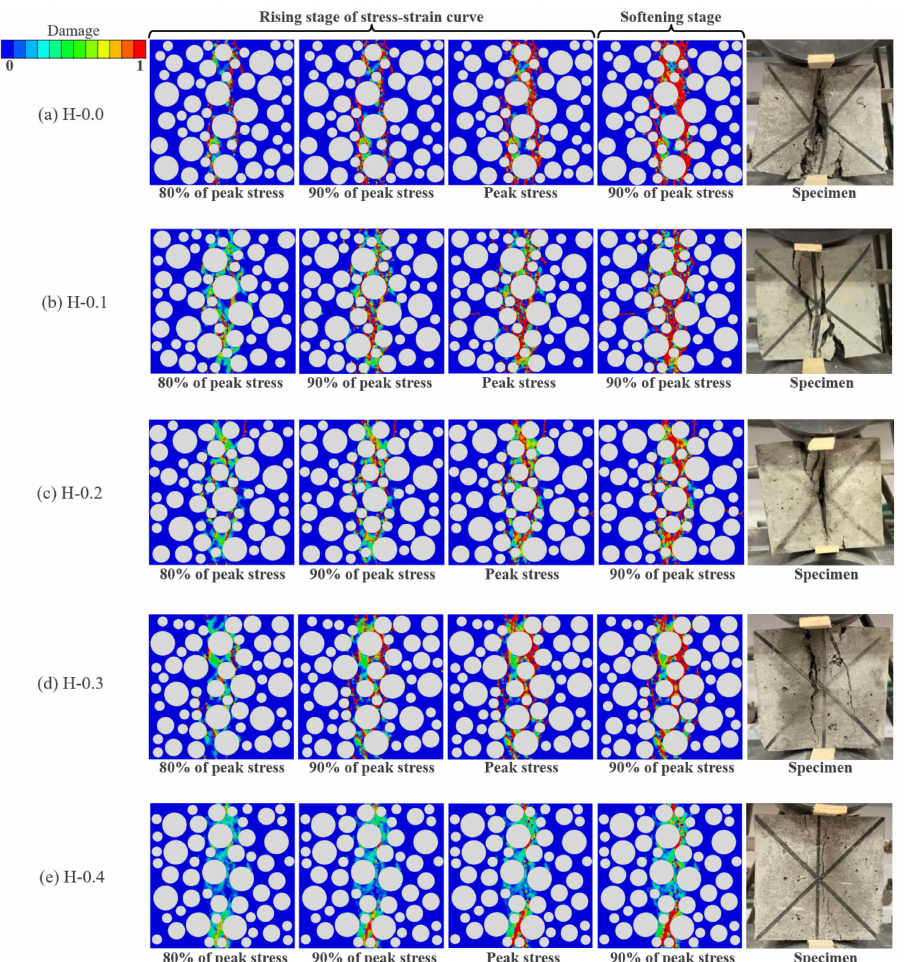
Figure 28. Mesoscale simulation of splitting tensile damage process of LHPCC with different hybrid fiber content. ( a ) comparison of the failure model at different loading stages of the concrete without adding fibers; ( b ) comparison of the failure model at different loading stages of the concrete with fiber contents at 0.1%; ( c ) comparison of the failure model at different loading stages of the concrete with fiber contents at 0.2%; ( d ) comparison of the failure model at different loading stages of the concrete with fiber contents at 0.3%; ( e ) comparison of the failure model at different loading stages of the concrete with fiber contents at